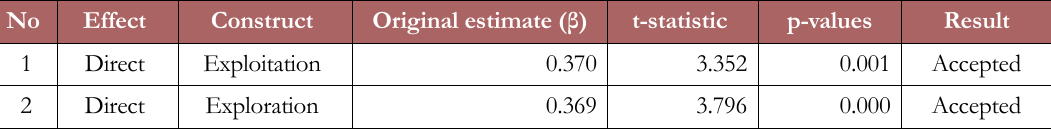
Table 10. Hypothesis test result for exploration and exploitation to OA in service